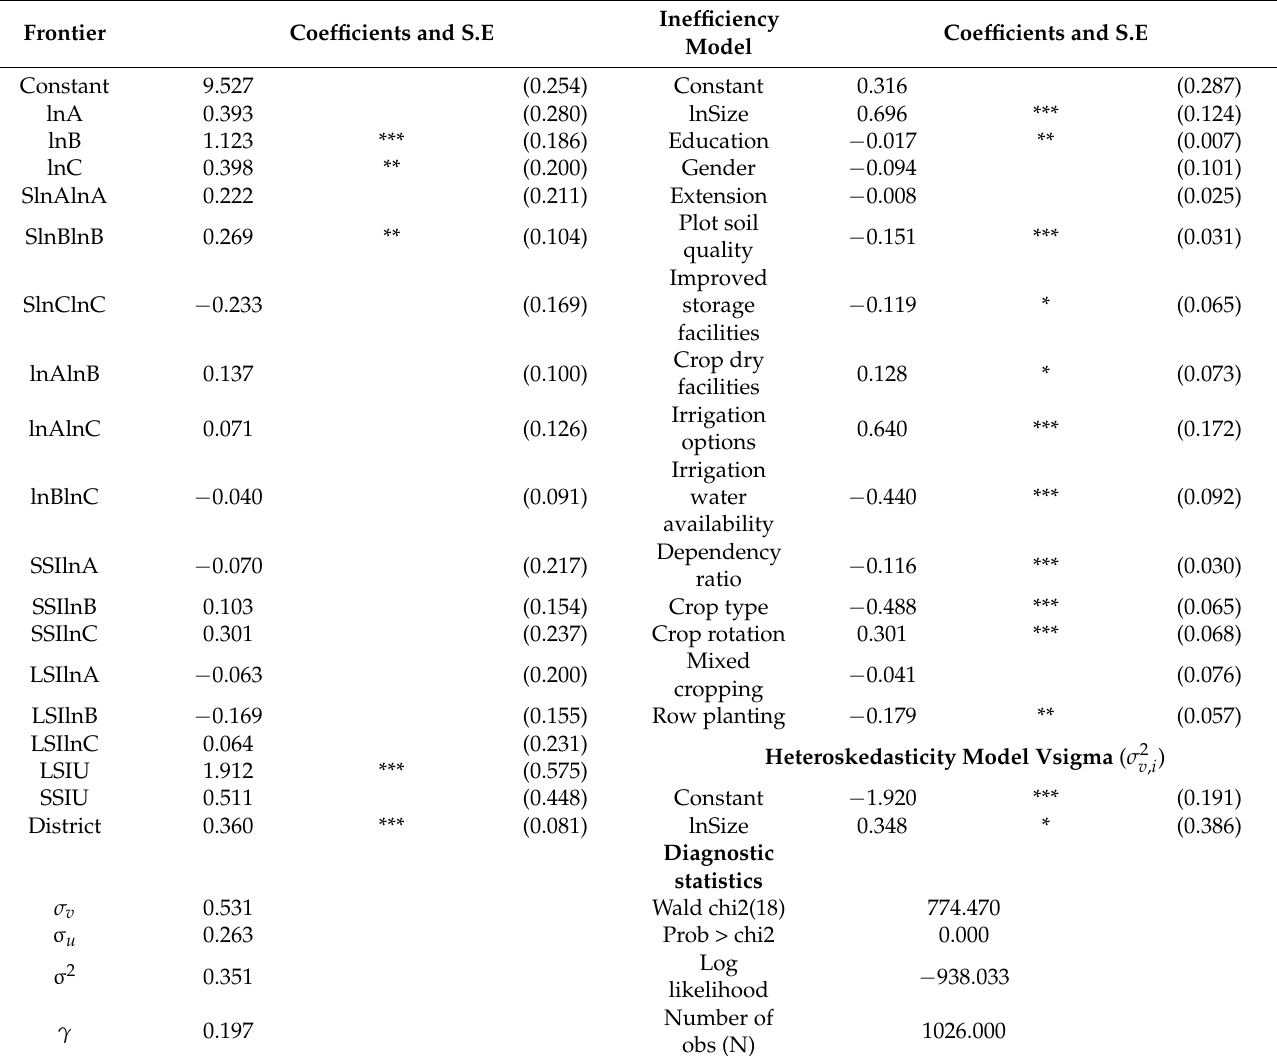
Table 3. Results of translog SFPF model